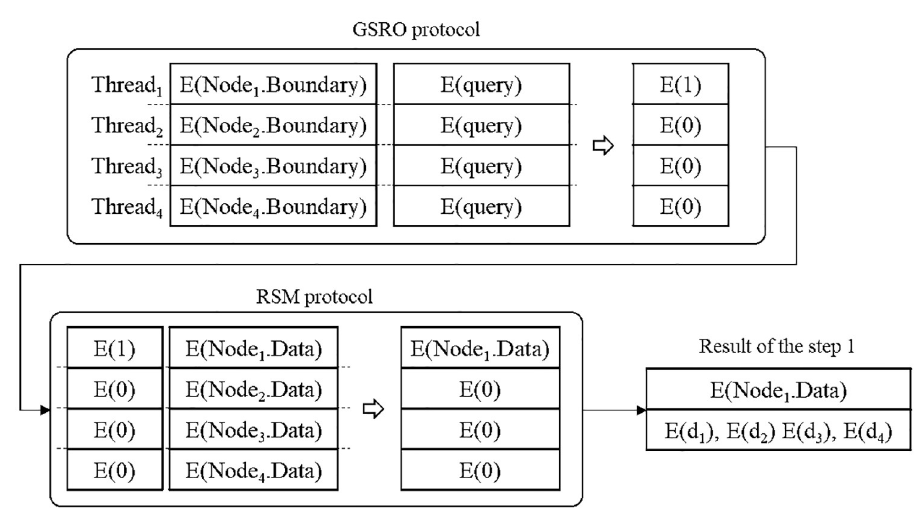
Fig 5. Example of secure index search phase.